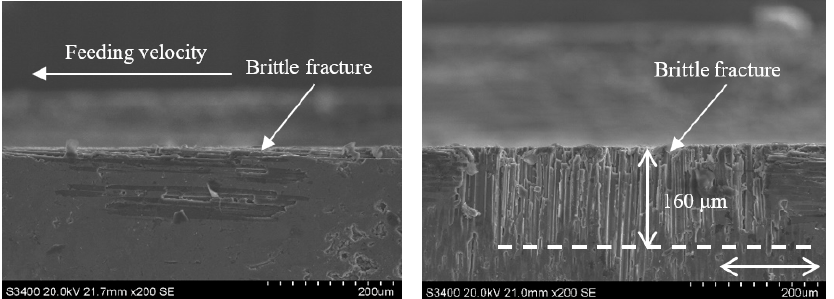
Figure 17. Grinding subsurface topography of the UAG-C/SiC composite (v s = 1.26 m/s, a p = 0.1 mm, v w = 100 m/min).